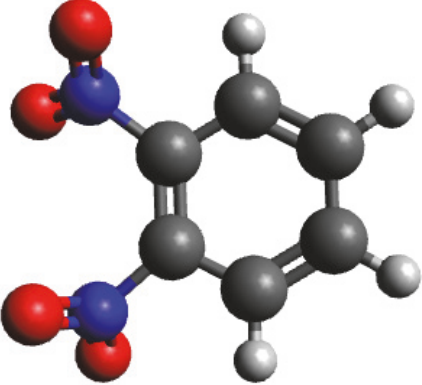
Figure 9: The lowest energy conformation of orthodinitrobenzene.